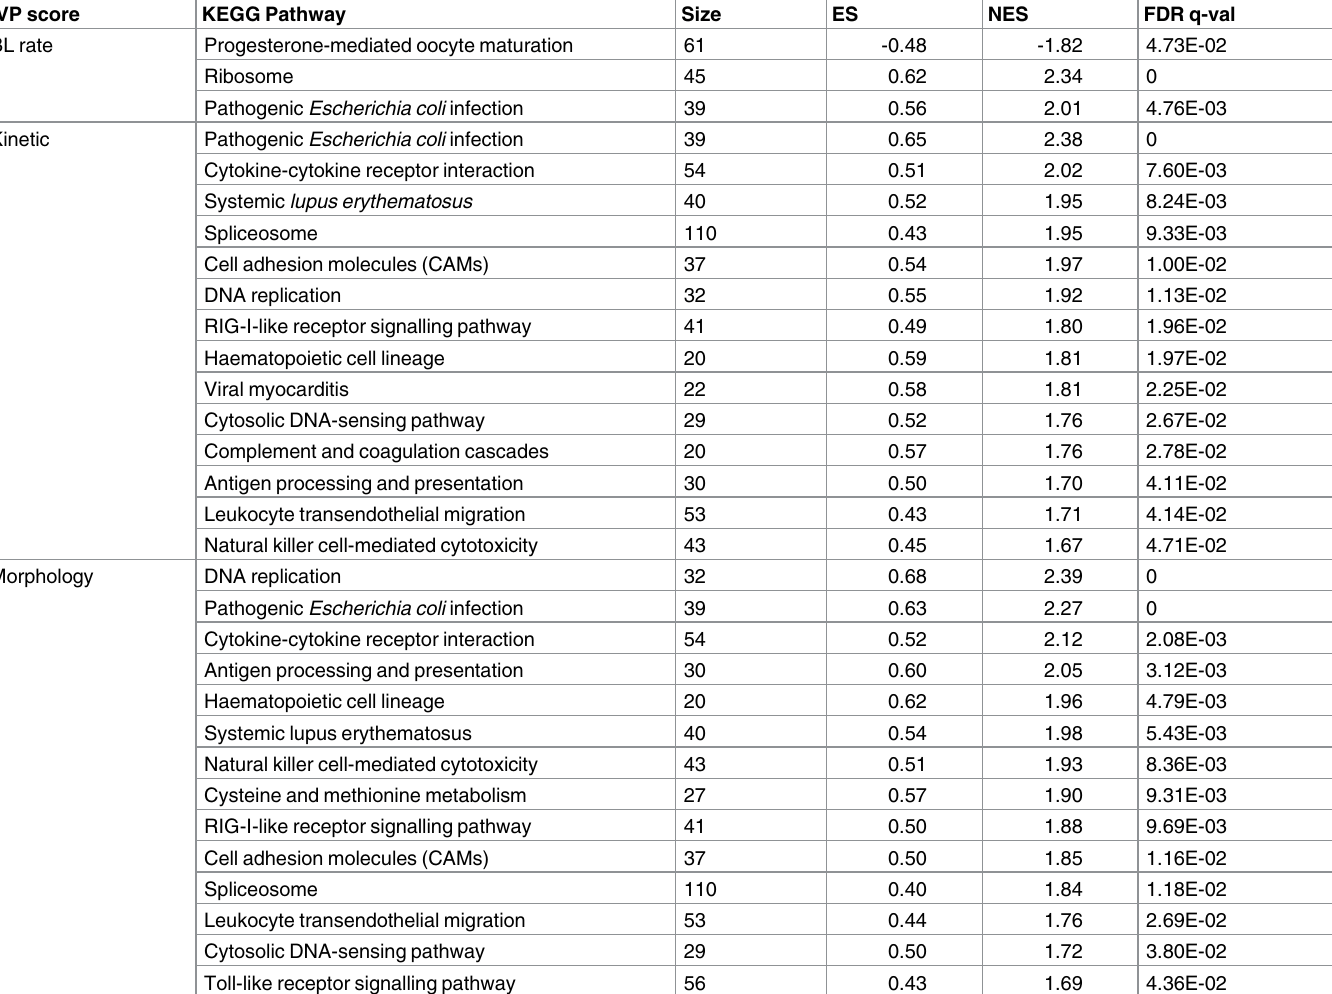
Table 5. Significant enriched KEGG pathways (FDR < 5%) identified from GSEA for all the IVP scores analysed. IVP score